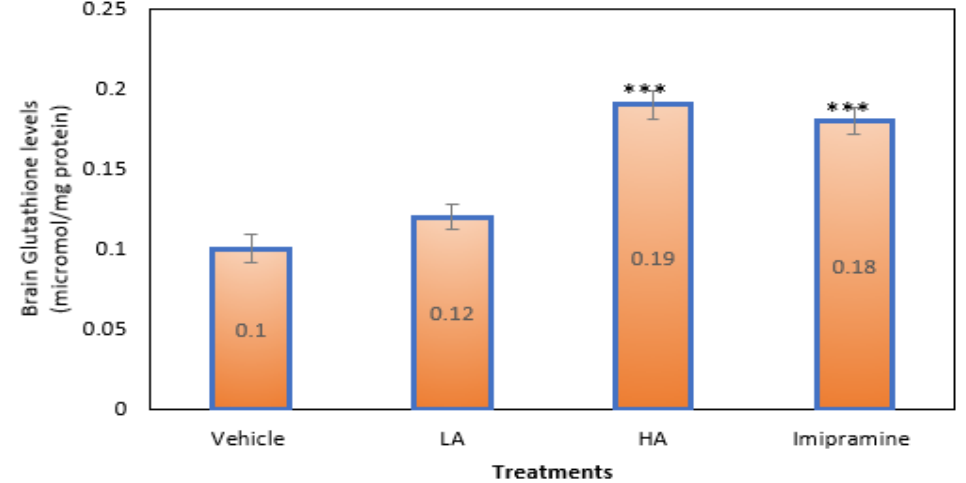
Figure 7. The effect of apigenin and imipramine on brain-reduced glutathione levels. Data are expressed in mean ± SEM (n = 8). Data were evaluated using a one-way analysis of variance (ANOVA) and Tukey’s test. *** p < 0.001 when compared to the vehicle control group. LA: low dose of Apigenin (25 mg/kg); HA: high dose of Apigenin (50 mg/kg); Imipramine: standard antidepressant (15 mg/kg); Vehicle; 0.2% carboxy methyl cellulose (CMC).